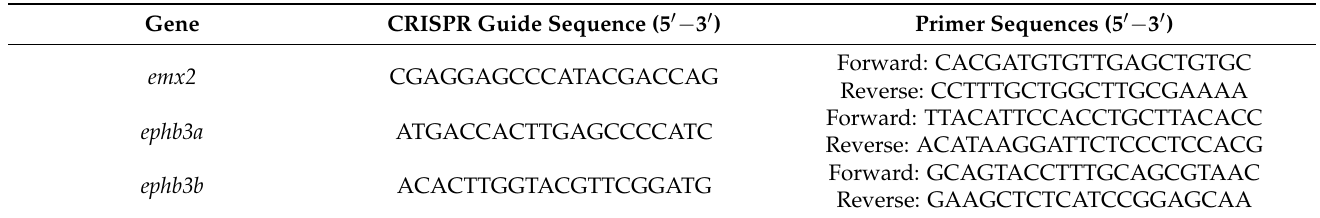
Table 2. Oligonucleotide sequences used for zebrafish gene editing and genotyping. Gene CRISPR Guide Sequence (5 (cid:48) − 3 (cid:48)